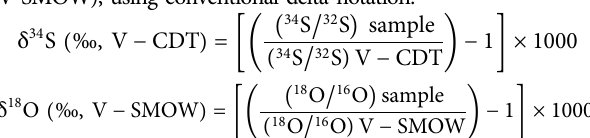
Frontiers in Earth Science |